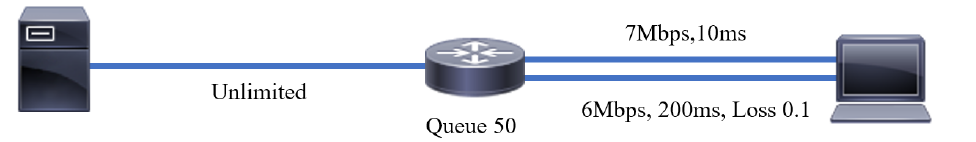
Figure 15. Network configuration to evaluate the performance of adaptive bitrate.